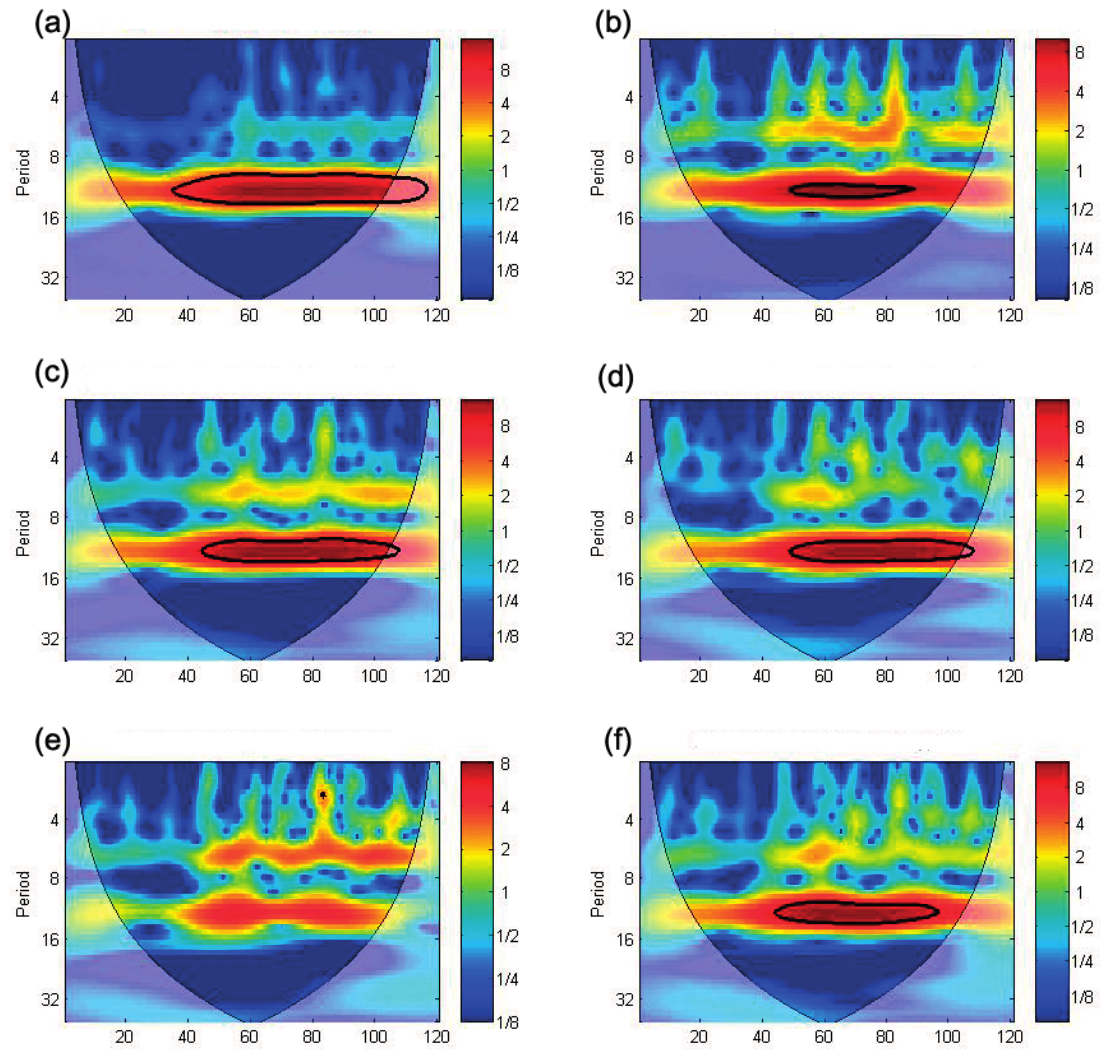
Figure 10. Cross wavelet analysis between scrub typhus and raw meteorological predictors (non-removed seasonality): scrub typhus with ( a ) mean temperature; ( b ) precipitation; ( c ) relative humidity; ( d ) wind speed; ( e ) duration of sunshine, and ( f ) cloud cover; bold line indicates 95% confidence inbound which is statistically significant and white transparency area indicates un-confidence area, and blue to red colors indicate the temporal correlation scale with each color-map